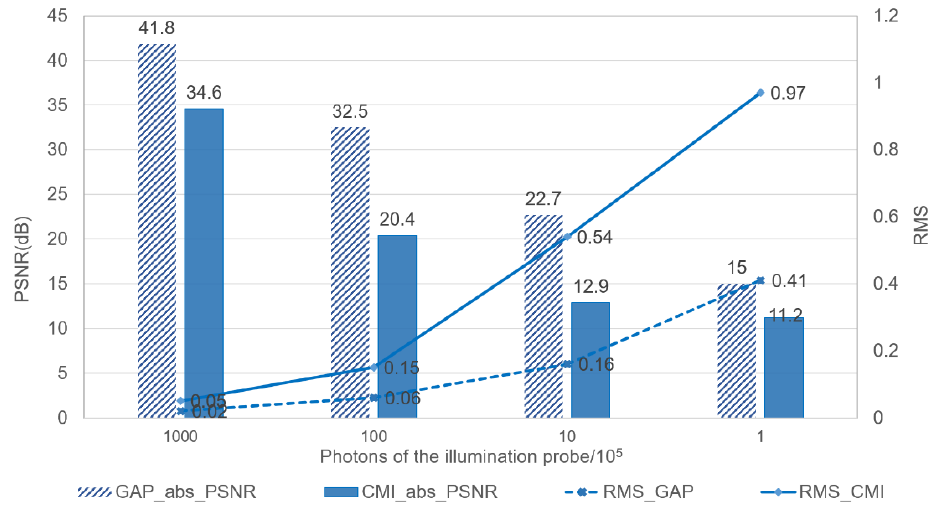
Figure 3. Error metrics comparison of reconstruction in our simulation for a near-field dataset when 𝑁 = 10 8 , 10 7 , 10 6 , 10 5 . Bar charts: PSNR comparison of reconstructed amplitudes under two algorithms. Line graphs: RMS comparison of reconstructed amplitudes under two algorithms.